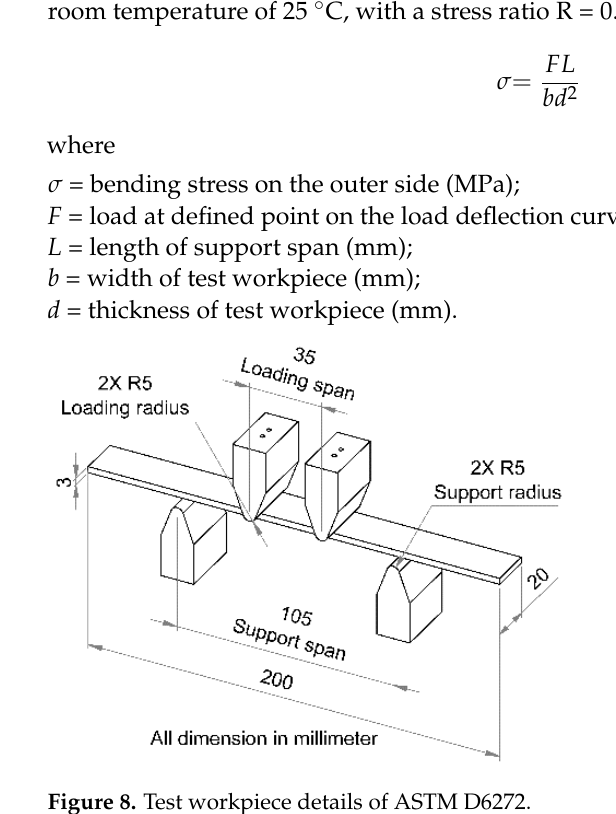
Figure 8. Test workpiece details of ASTM D6272.